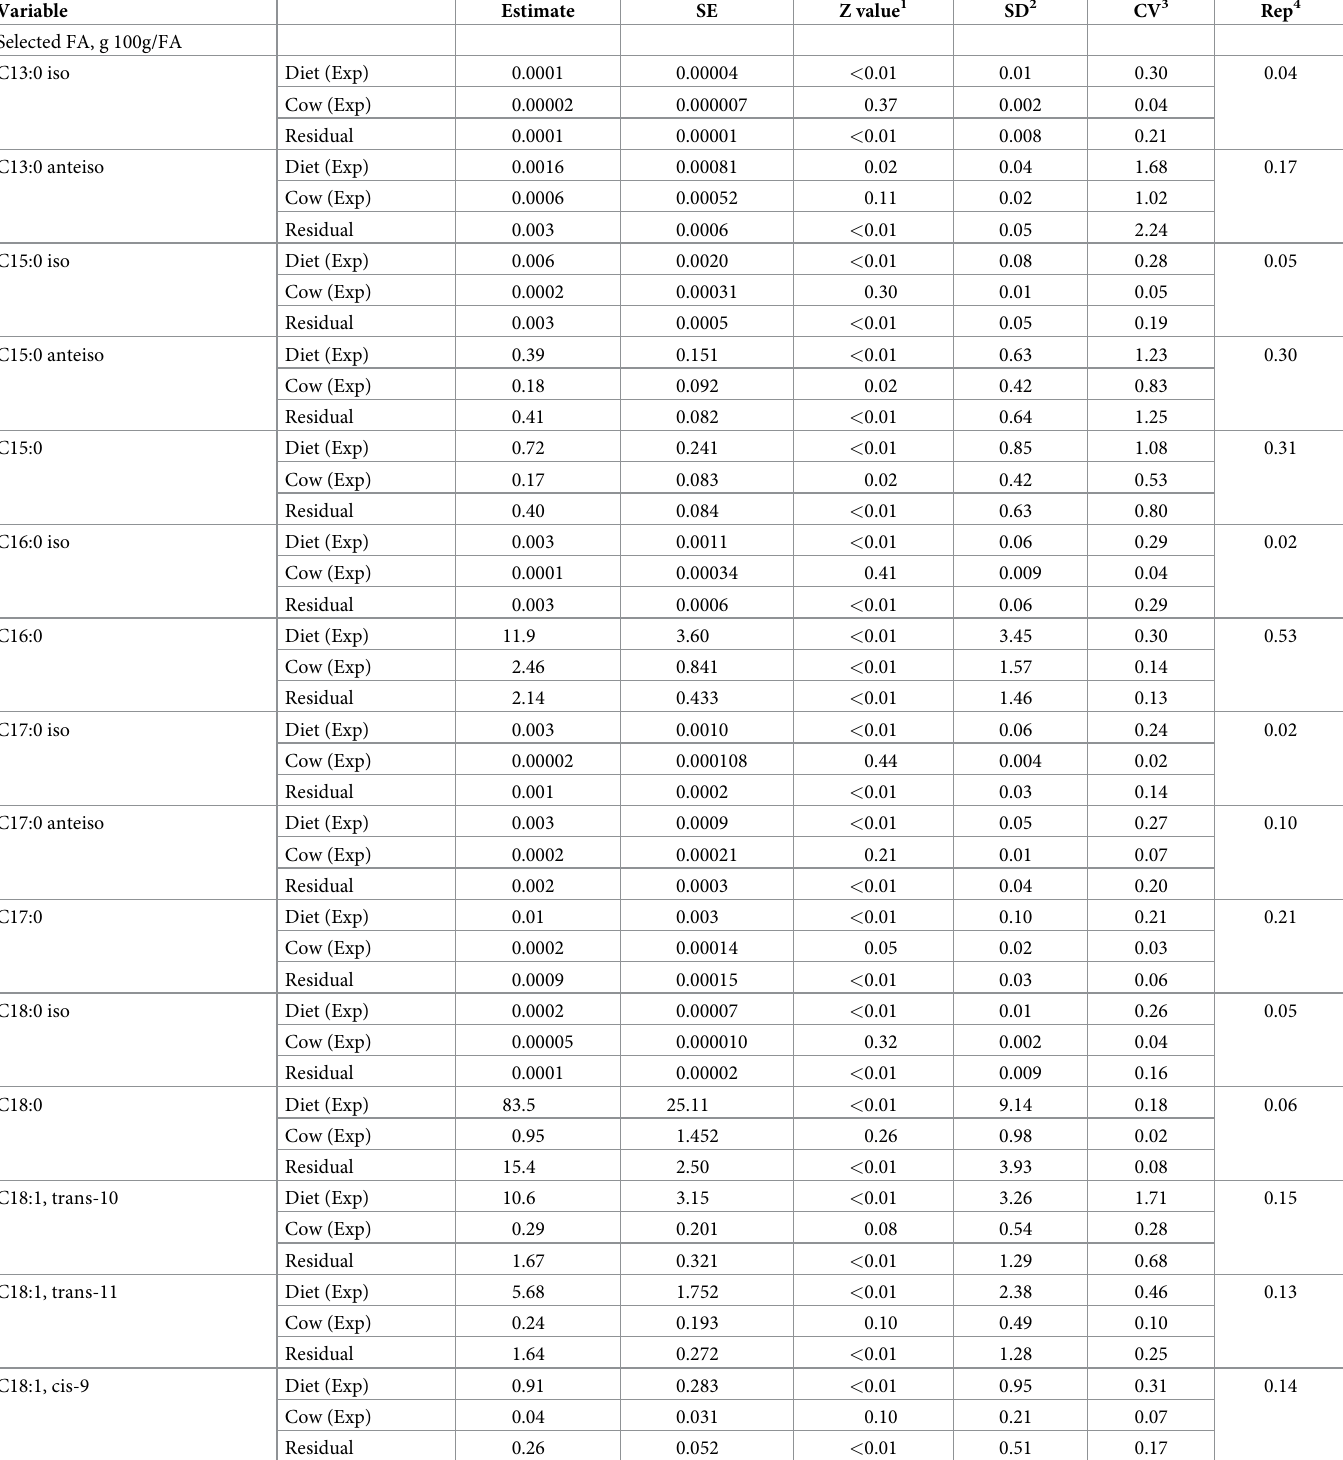
Table 5. Variance component estimates of omasal fatty acids (FA) in dairy